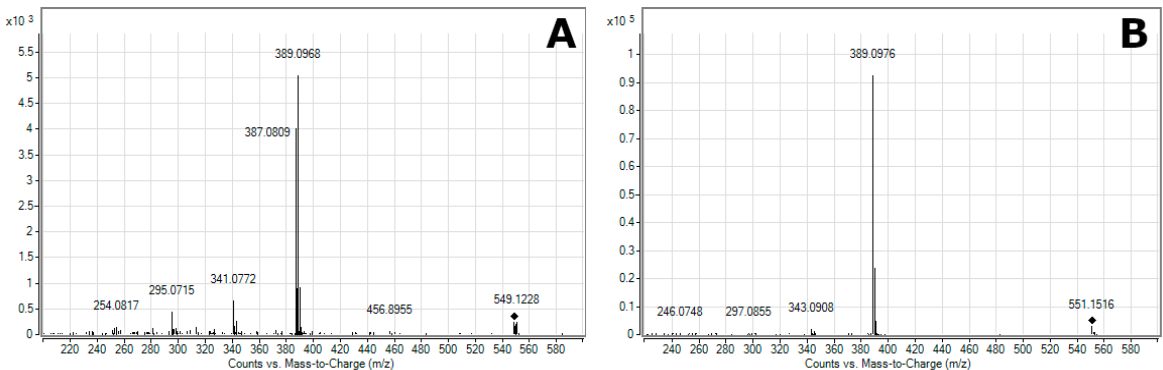
Figure 2. Positive electrospray tandem mass spectra for ( A ) neobetanin, and ( B ) betanin or isobetanin. The daughter ion of m / z 387.0809 was obtained by fragmentation of the parent ion of m / z 549.1228 of neobetanin. The daughter ion of m / z 389.0976 corresponds to protonated aglycone, and was obtained by fragmentation of the parent ion of m / z 551.1516 of betanin or isobetanin. The collision energy was 10 eV and 30 eV for ( A ) and ( B ), respectively.